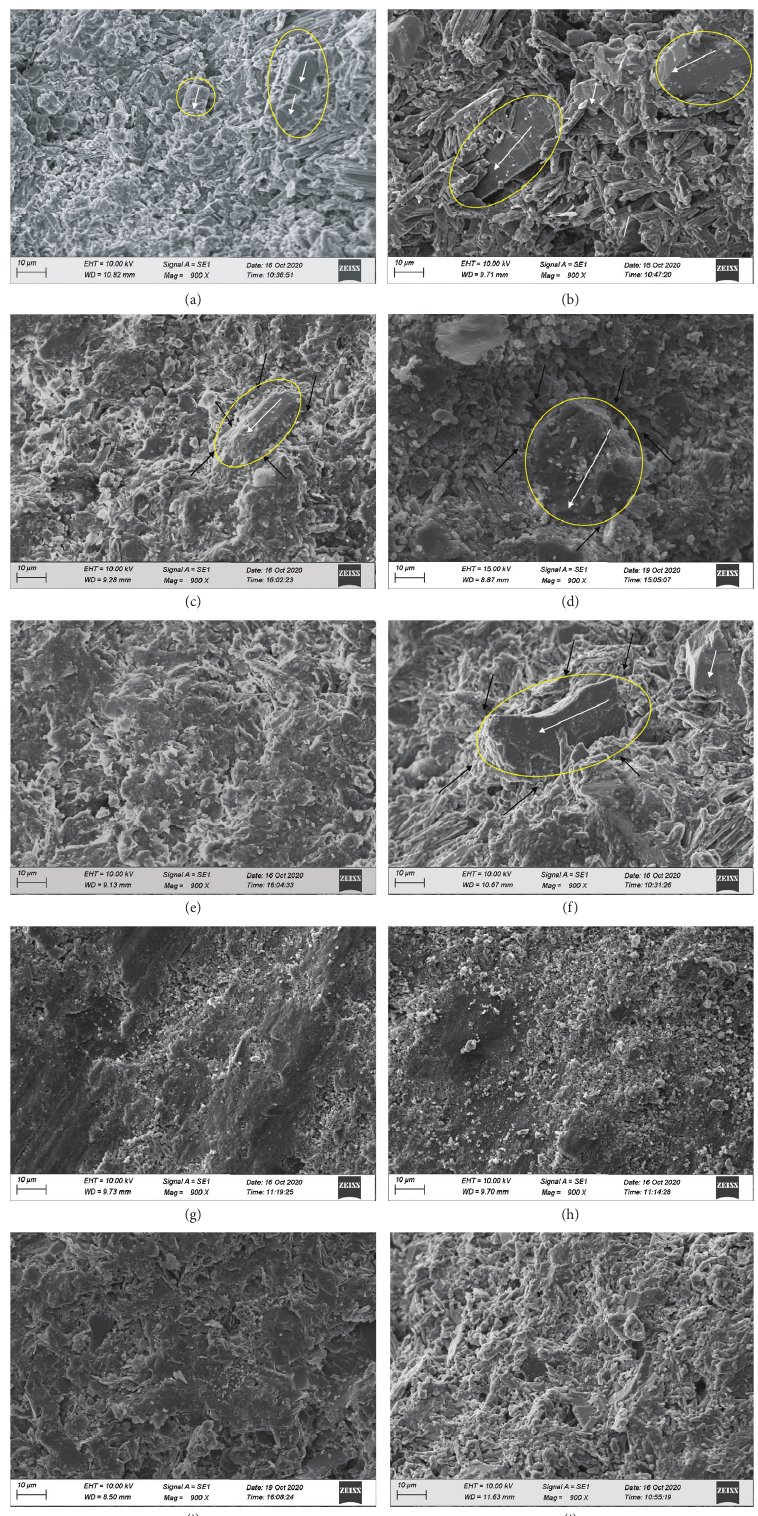
Figure 13: SEM images of raw rock and similar material specimens: (a,b) S1 specimen (0%); (c, d) S2 specimen (6%); (e, f) S3 specimen (12%); (g, h) S4 specimen (18%); (i, j) raw rock